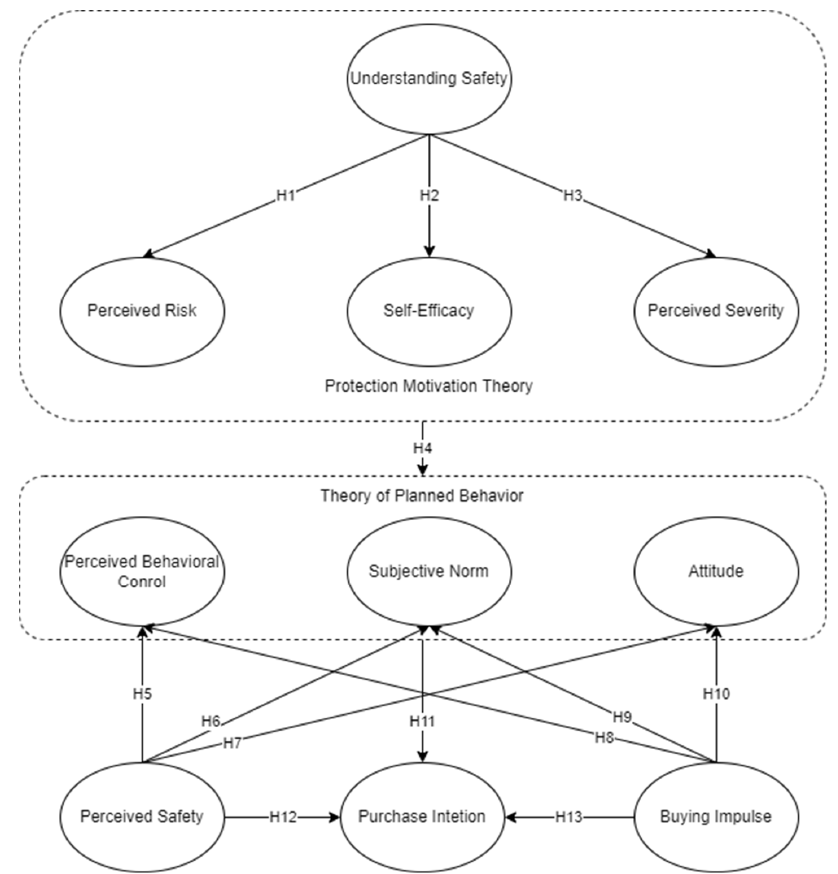
Figure 2. Conceptual Framework.